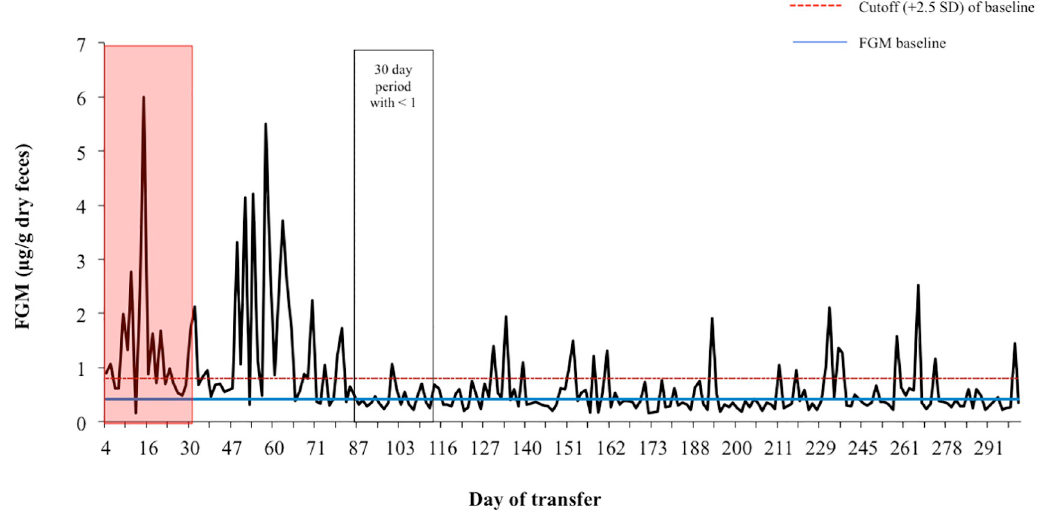
Fig 2. Representative fecal glucocorticoid metabolite profile of a fishing cat (SB# 721) that experienced an institutional transfer. The red shading indicates the time the cat spent in quarantine. The outlined box indicates the return to baseline, defined as 30 consecutive days with � 1 peak above 2.5 standard deviations of the individual’s overall baseline.